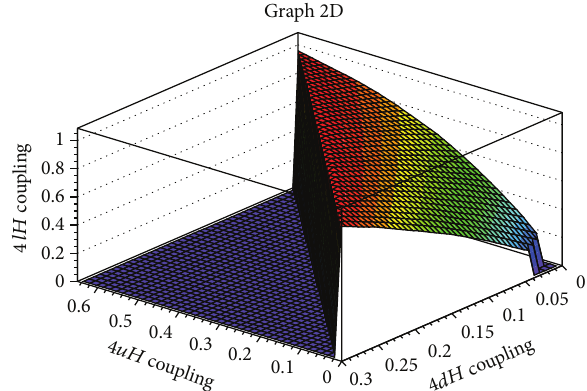
Figure 7: The dependence of the ratio 𝑅 on the suppression factors 4𝑞𝐻 and 4𝑙𝐻 of Higgs coupling to correspondingly quarks and leptons of the 4th generation.